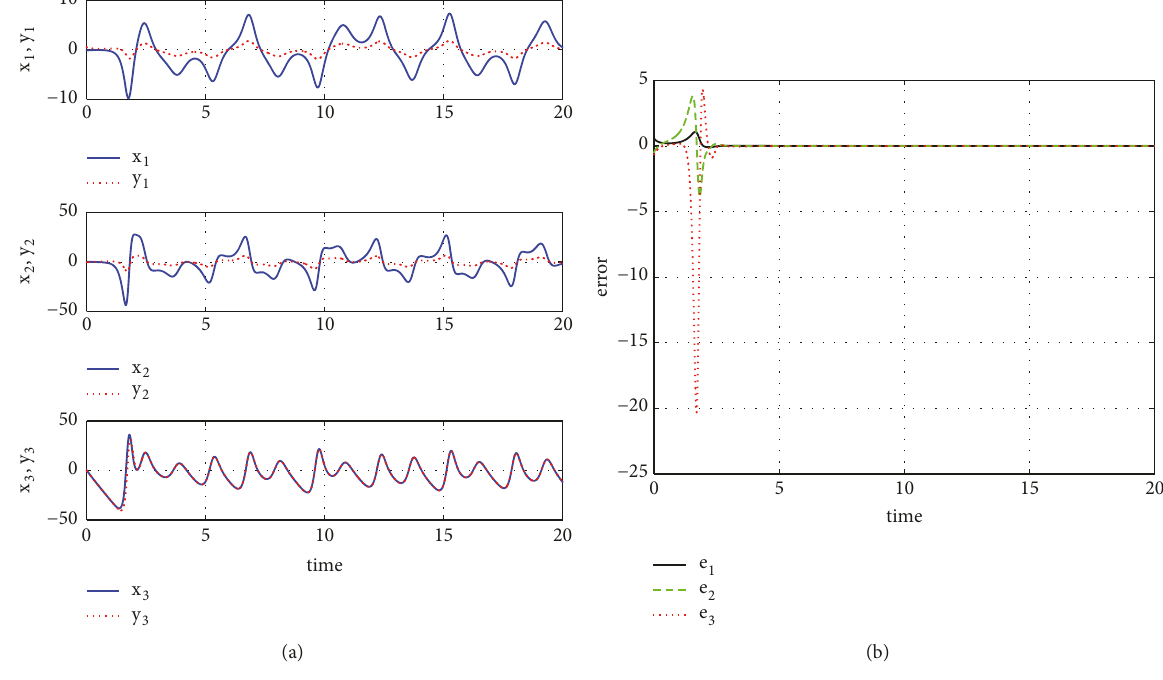
Figure 7: Partial projective synchronization with k 2 =6; k 3 =8: (a) time response; (b) synchronization error.